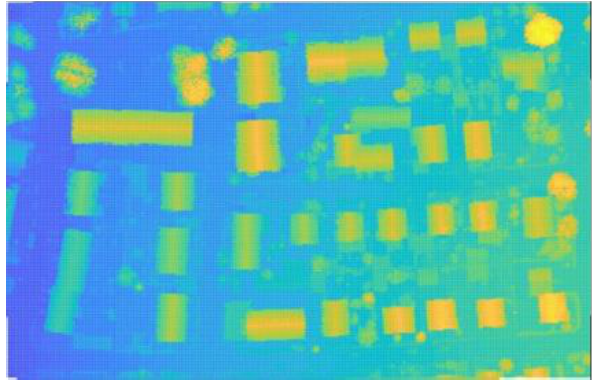
Figure 10. Reference data for building